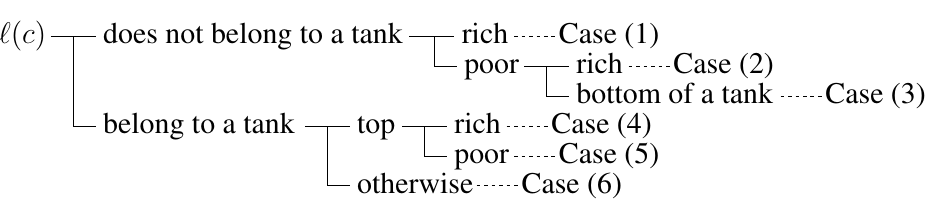
Figure 4. Execution of E XTENDED -L AZY for an insertion i